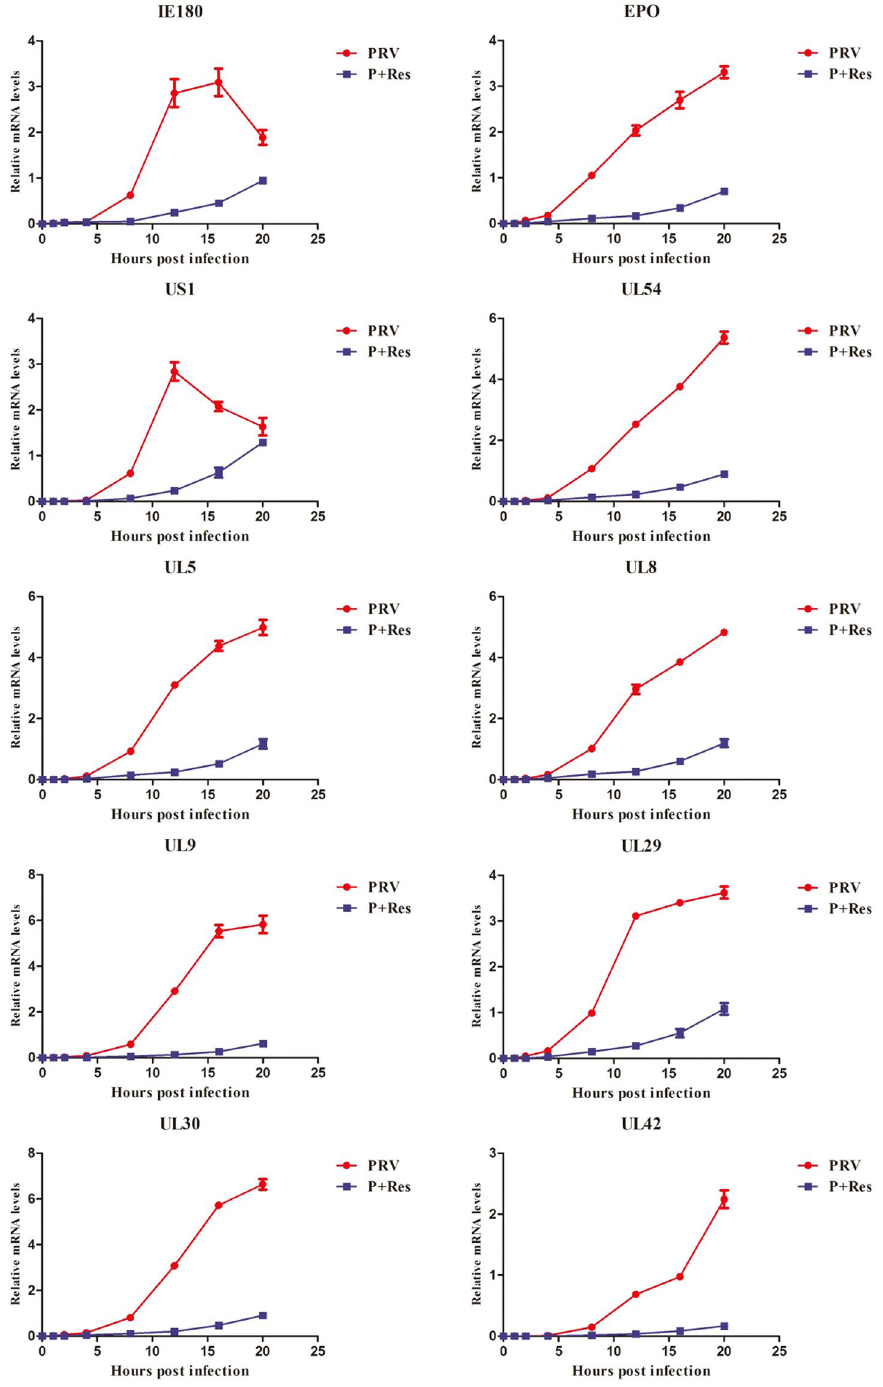
Figure 4. Res suppressed the expression of PRV genes. Gene expression levels of PRV in the presence or absence of Res (65.72 μ M) were assayed at 0, 1, 2, 4, 8, 12, 16 and 20 hpi (n = 3, in each